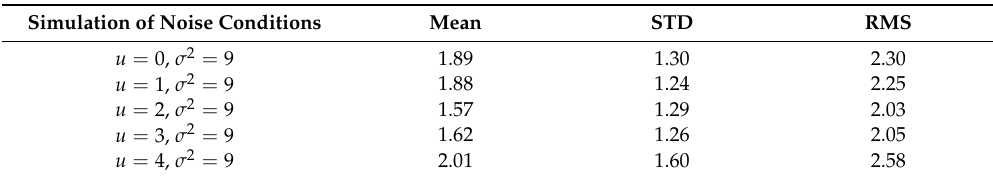
Table 5. Matching location accuracy in the simulation with variance = 9 mGal 2 and varying mean